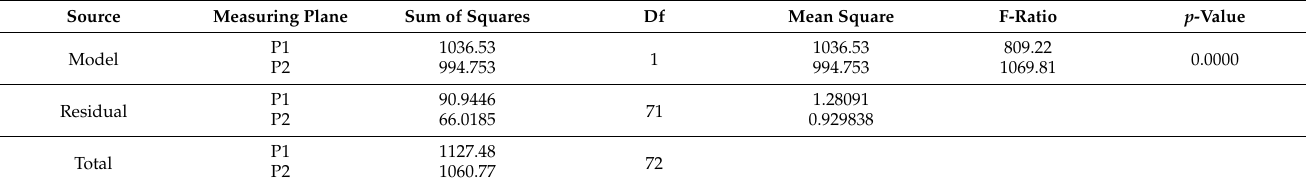
Table 6. Analysis of Variance.